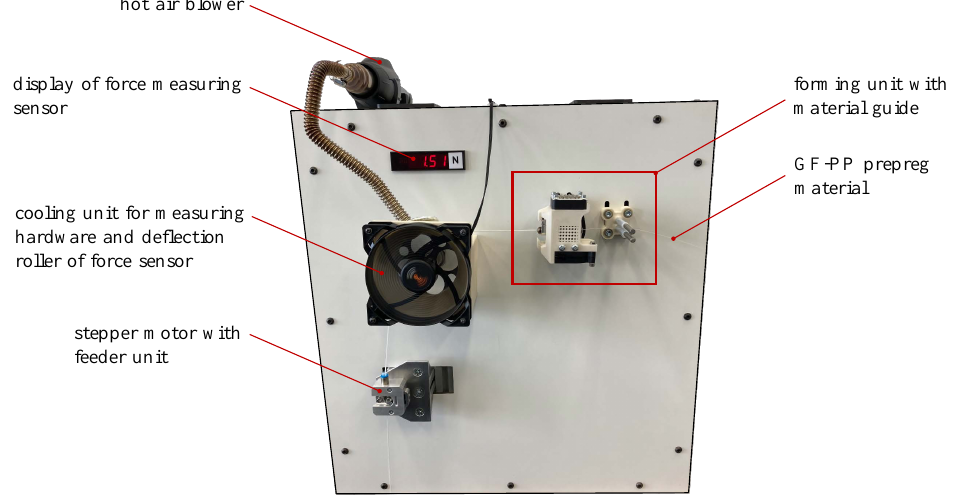
Figure 2. Test rig for the evaluation of deformation